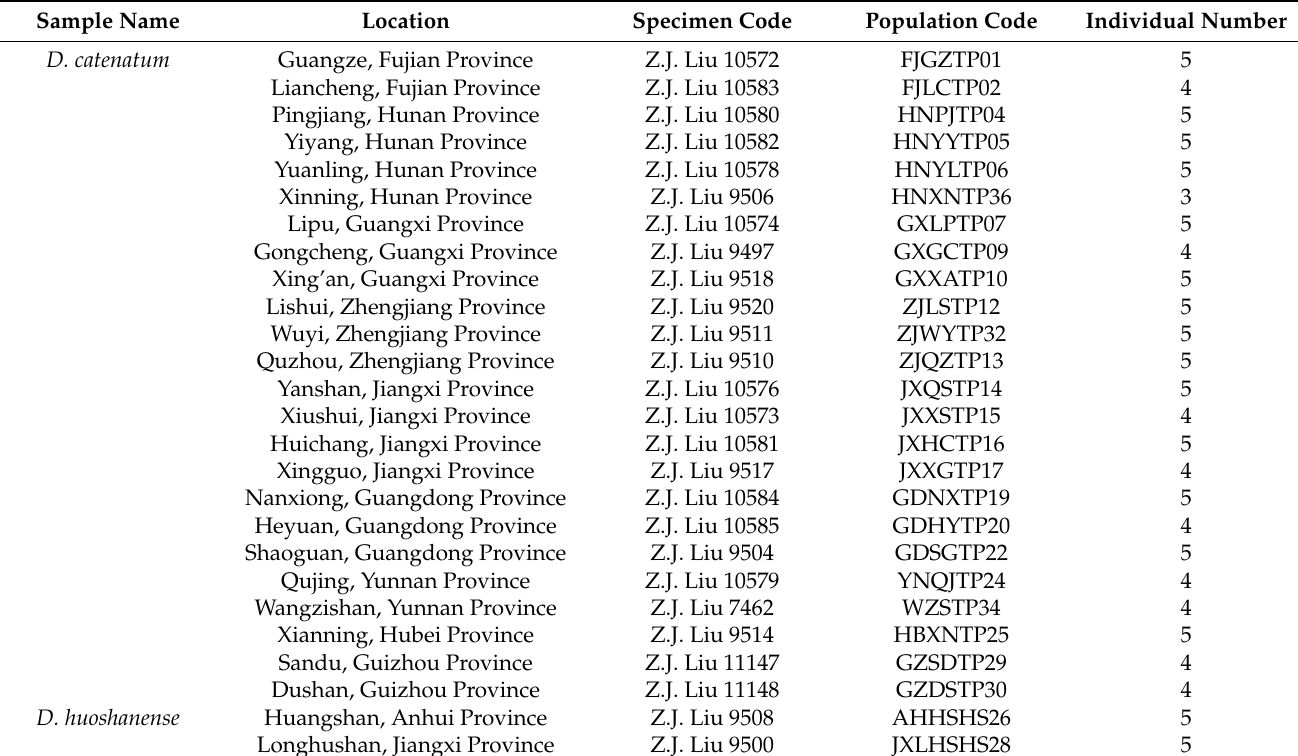
Table 1. Inthisstudy, thepopulationlocationsandvoucherinformationof D.catenatum and D.huoshanense